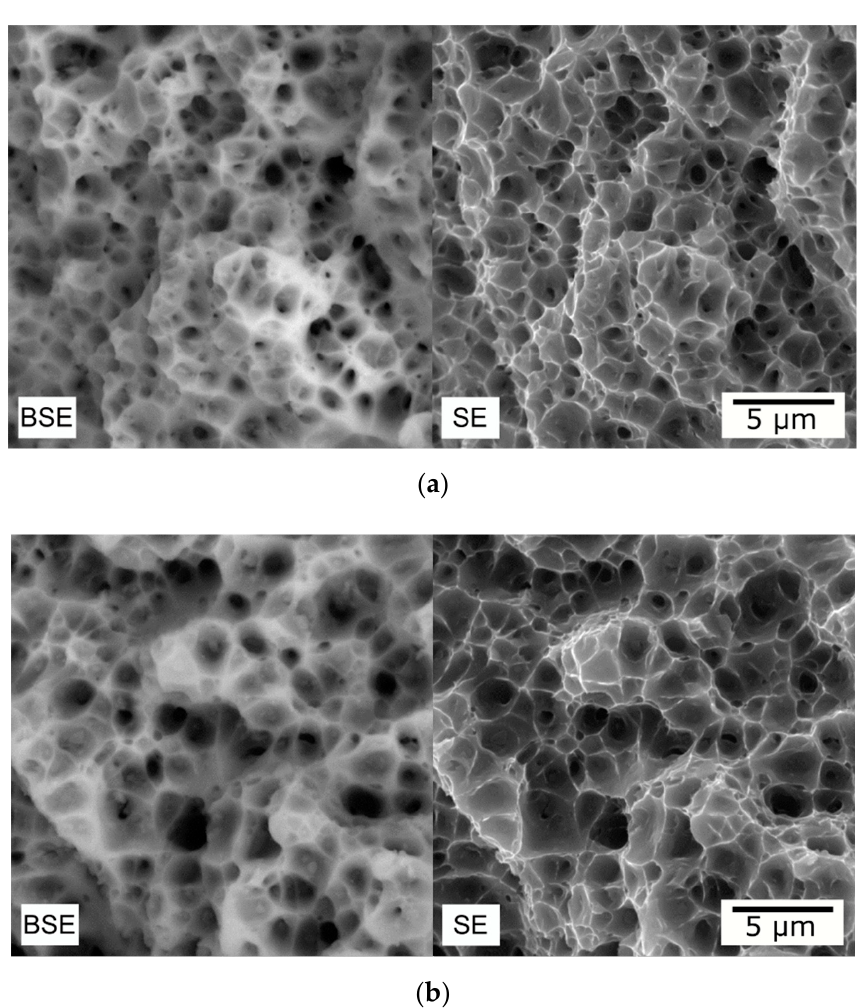
Figure 6. Fracture surfaces of experimental wire alloy ( a ) in initial (W) and ( b ) annealed (W450) states, SEM, left —backscattered electron image, right —secondary electron image, SEM.